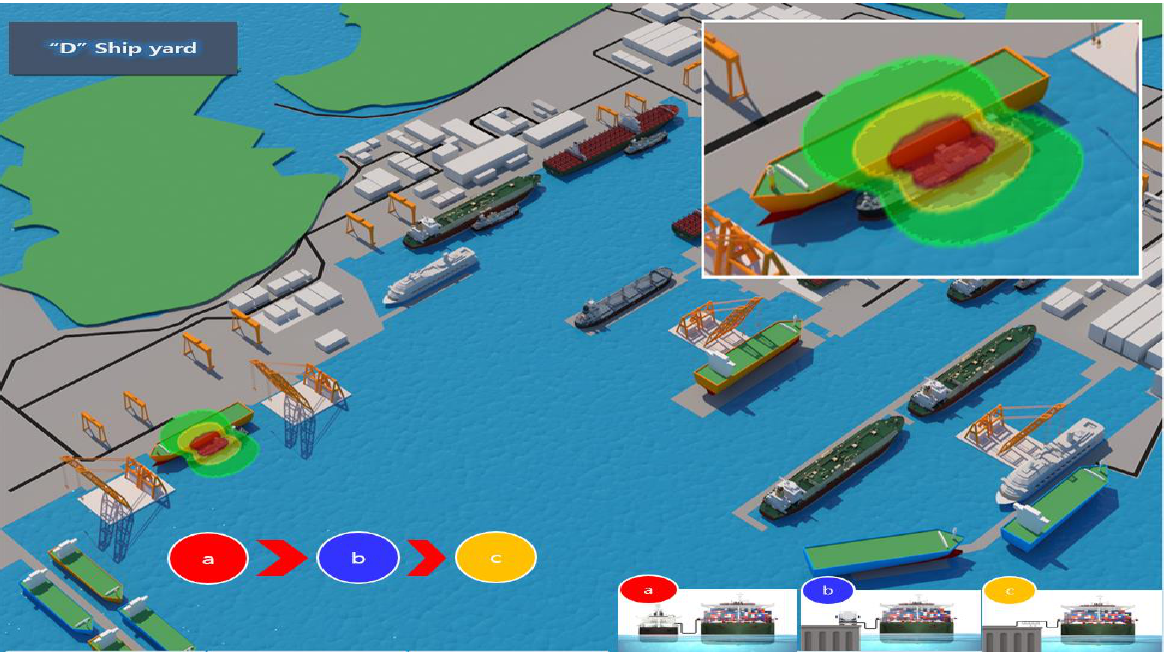
Figure 5. LNG bunkering arrangement diagram in shipyard “D” considering the priority of LNG bunkering method.